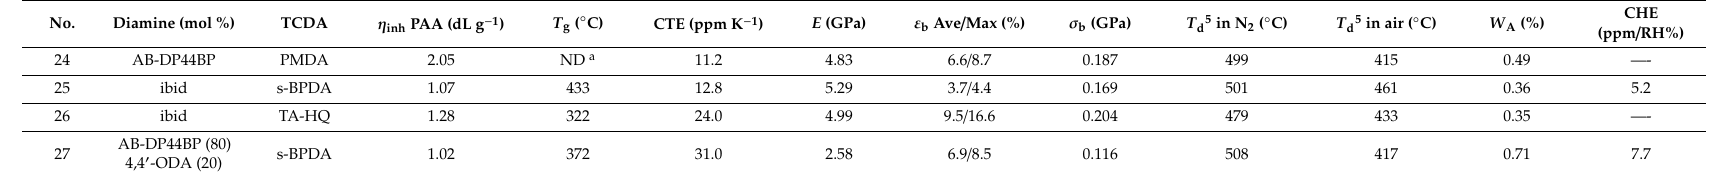
Table 7. Film properties of the PEsIs derived from AB-DP44BP (R = phenyl group) with tetracarboxylic dianhydrides